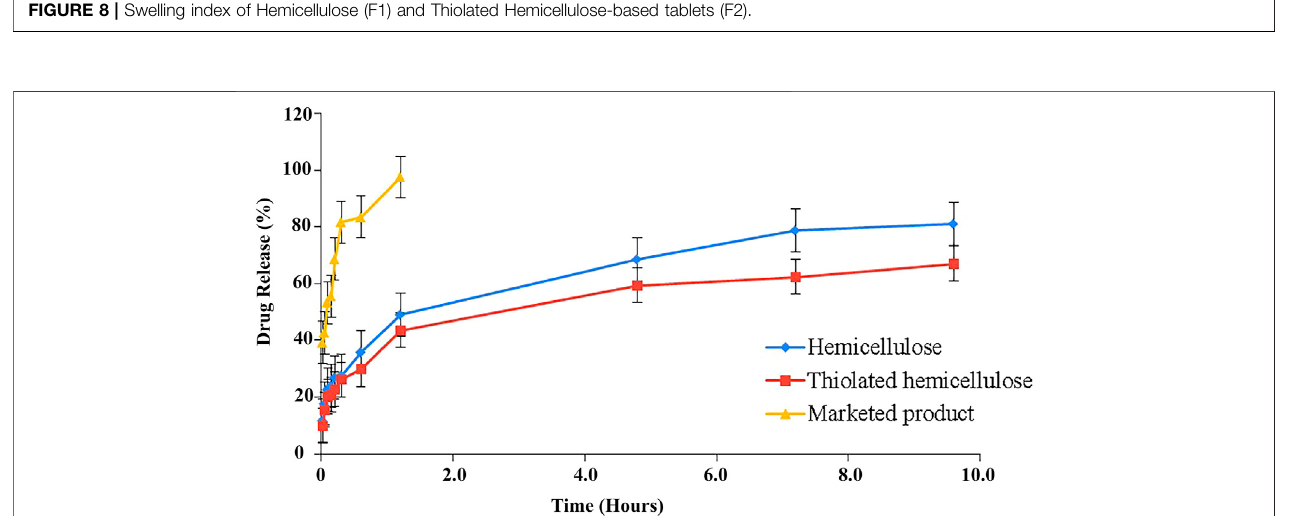
FIGURE9| Illustrationofdissolutionpro fi leofhemicellulose-based(F1)andthiolatedhemicellulose-basedtabletofTicagrelor(F2)andtheircomparison withthe% drug release of MP (marketed product).